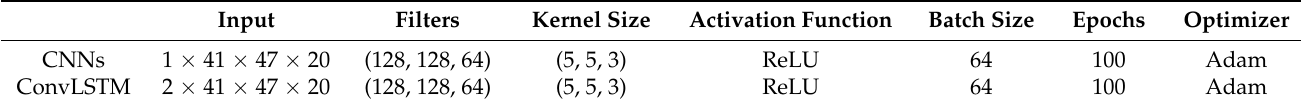
Table 1. CNNs and ConvLSTM network parameters.